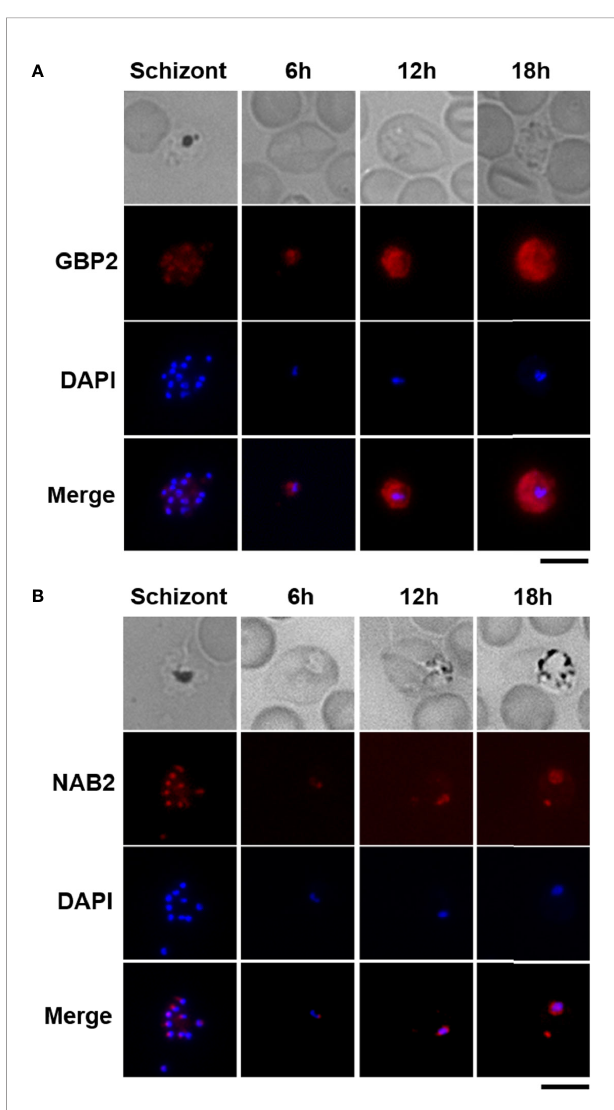
FIGURE 2 | Live-cell fl uorescence imaging of GBP2::mCherry- and NAB2:: mCherry-expressing parasites. Erythrocytes infected with P. berghei ANKA schizonts at 22 h after incubation were analyzed (Schizont). Female B6 mice were infected intravenously with 5 × 10 6 to 5 × 10 7 mature schizonts harvested by Nycodenz density gradient centrifugation of a given parasite strain. Erythrocytes infected with malaria parasites at 6 h (ring form), 12 h (trophozoite), and 18 h (late trophozoite) after inoculation were analyzed (6, 12, and 18 h). At least 50 infected erythrocytes were analyzed, and the same fl uorescence pattern was observed in all infected erythrocytes. (A) Transgenic parasites expressing mCherry-fused GBP2. (B) Transgenic parasites expressing NAB2 fused to mCherry. Scale bar = 5 µm. Experiments were performed in triplicate. Representative data are